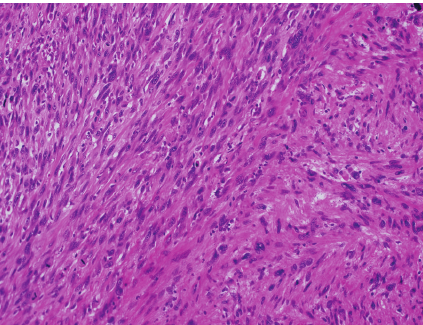
Figure 3: Microscopic finding. Spindle shaped leiomyosarcoma cells (right side) and what appeared to be MFH with a high mitotic rate (left side). Hematoxylin and eosin stain × 20 (upper).